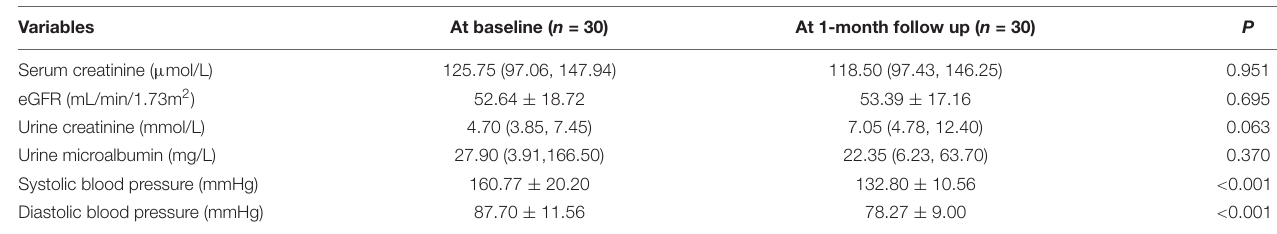
TABLE 3 | Comparison of global renal function and blood pressure at baseline and 1-month follow-up.